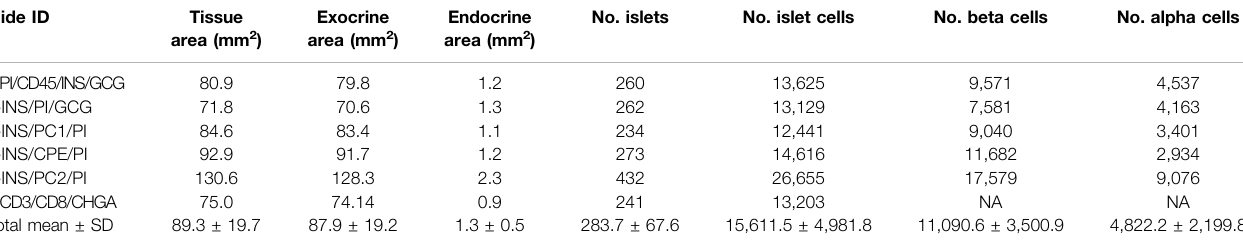
TABLE 1 | Characterization of the endocrine and the exocrine pancreas of a non-diabetic donor according to different staining combinations. Slide